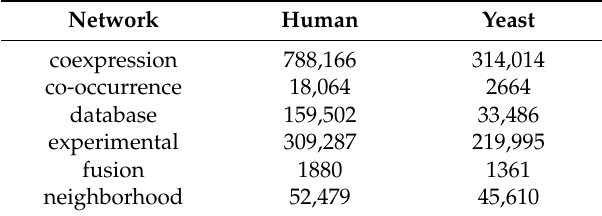
Table 1. Interaction network and its corresponding number of